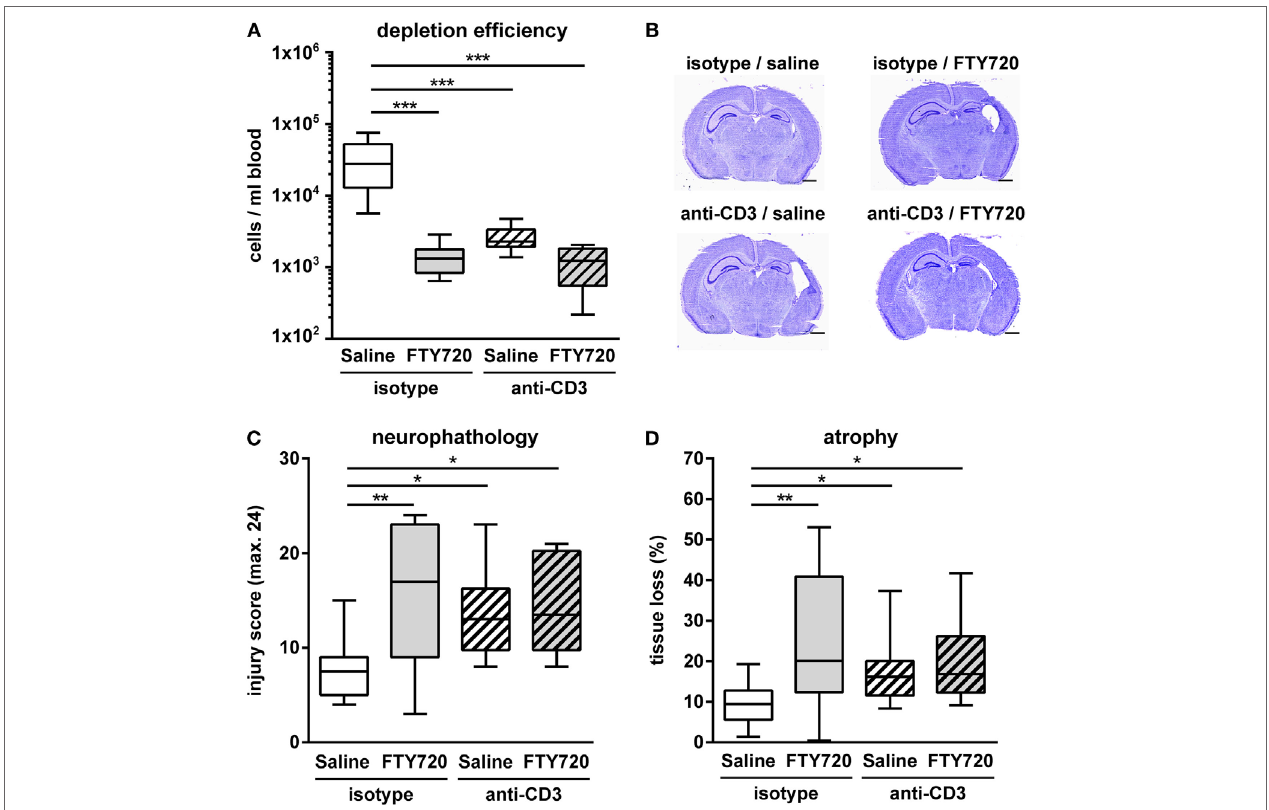
FigUre 7 | Exacerbation of HI-induced brain injury by FTY720 is dependent on peripheral T cells. Whether FTY720s’ detrimental effect could be attributed to its T cell depleting effect was determined in anti-CD3-treated animals. P9 mice were exposed to HI followed by a single intraperitoneal injection of 1 mg/kg FTY720 or 0.9% NaCl (saline). Anti-CD3 treatment was started on P8 followed by repetitive injections every 48 h according to our previous report (26). Control mice received an isotype control antibody. One week after HI, depletion efficiency by antibody- and FTY720-treatment as well as in the combined setting was analyzed in the peripheral blood via flow cytometry (a) . Brain injury was evaluated on cresyl violet stained tissue sections on P16 (B,c) . Neuropathological assessment was performed according to a previously described scoring system in eight regions. Each region was given a rating from 0 to 3 (0—no detectable cell loss, 1—small focal areas of neuronal cell loss, 2—columnar damage in the cortex or moderate to severe cell loss in the other regions, 3—cystic infarction and gliosis). The sum score from different regions (cortex, hippocampus, and striatum) was calculated for each animal resulting in a total maximum score of 24 (c) . Brain tissue atrophy was determined by measurement of intact areas in ipsilateral and contralateral hemispheres using Image J. Tissue loss was determined by comparison with contralateral values (D) . Anti-CD3 and FTY720-mediated T cell depletion significantly increased HI-induced injury. The combined treatment resulted in a similar degree of injury compared to single treatments. n = 8–10/group for (a) , n = 10–14/group for (B–D) , one-way ANOVA with Bonferroni post hoc test for (a,c) , Kruskal–Wallis with Dunn’s multiple comparison test for (D)